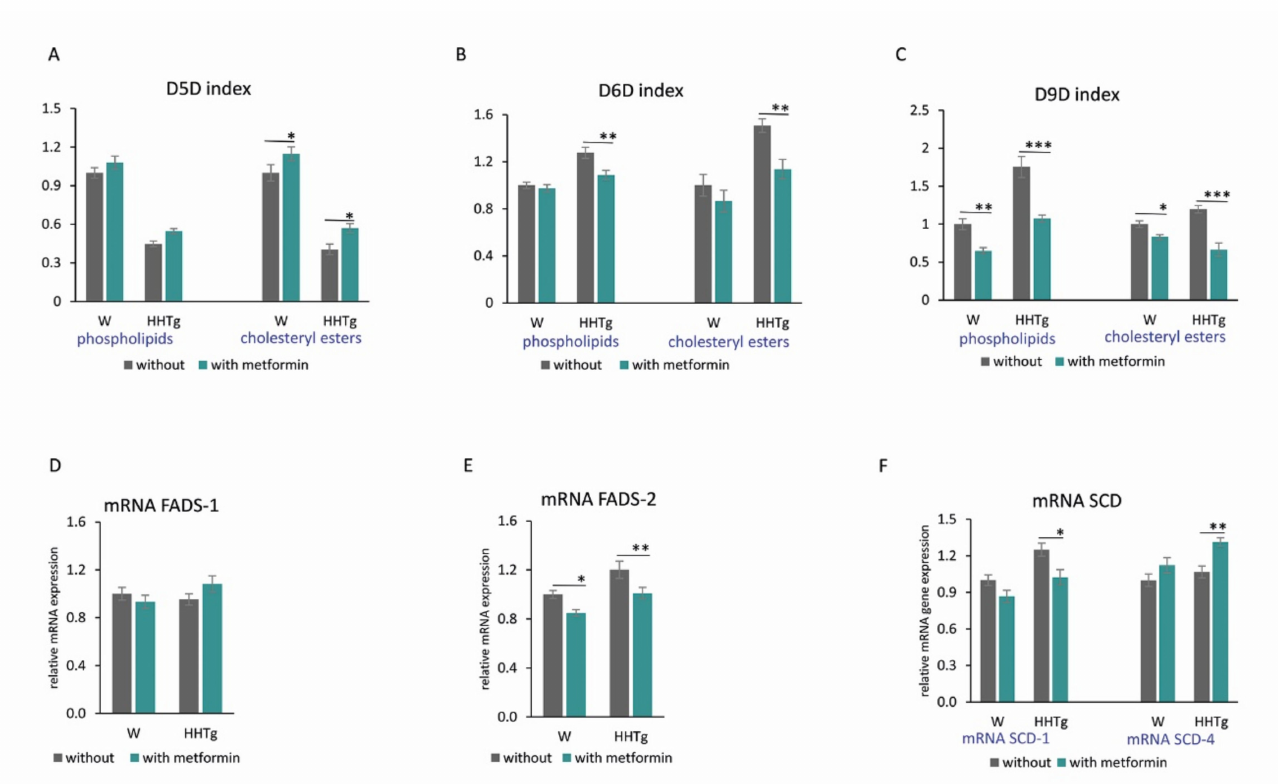
Figure 3. Effects of metformin on relative mRNA expression ( D – F ) and activity (desaturation index) ( A – C ) of the desaturases SCD-1, FADS-1 and FADS-2 in myocardium of Wistar control (W) and hereditary hypertriglyceridemic (HHTg) rats. Data are mean ± SEM; n = 8 for each group. Significance was determined using two-way ANOVA and Fisher’s LSD post-hoc test (* denotes p < 0.05; ** denotes p < 0.01; *** denotes p <